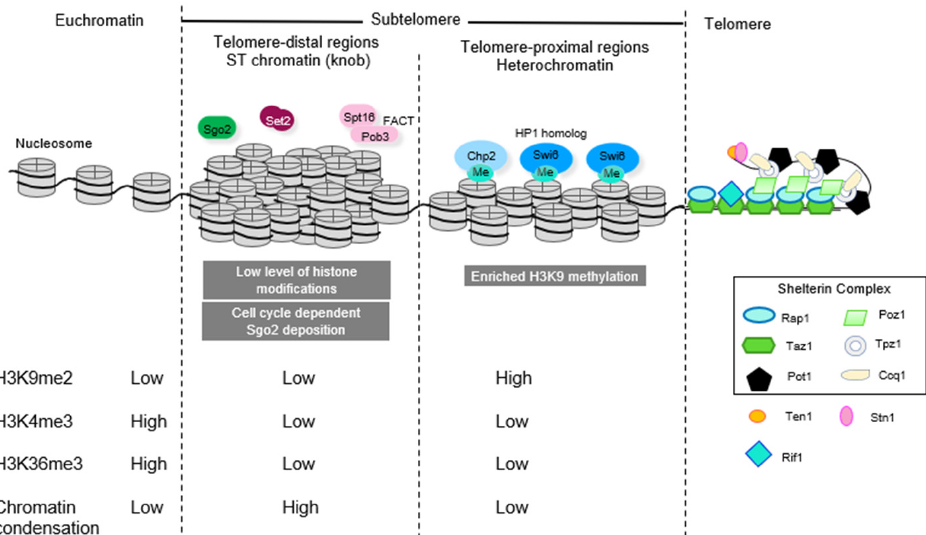
Figure 1. Subtelomeric chromatin domains consist of (1) heterochromatic telomere-proximal domains characterized by high levels of heterochromatic histone marks (H3K9me2) and a paucity of marks associated with transcriptional activity (H3K4me3) and bound by HP1 homolog proteins Swi6 and Chp2 and (2) telomere distal ST domains, where there is a paucity of histone modification and instead chromatin is highly condensed and associated with Shugoshin protein Sgo2 to form “knobs”.